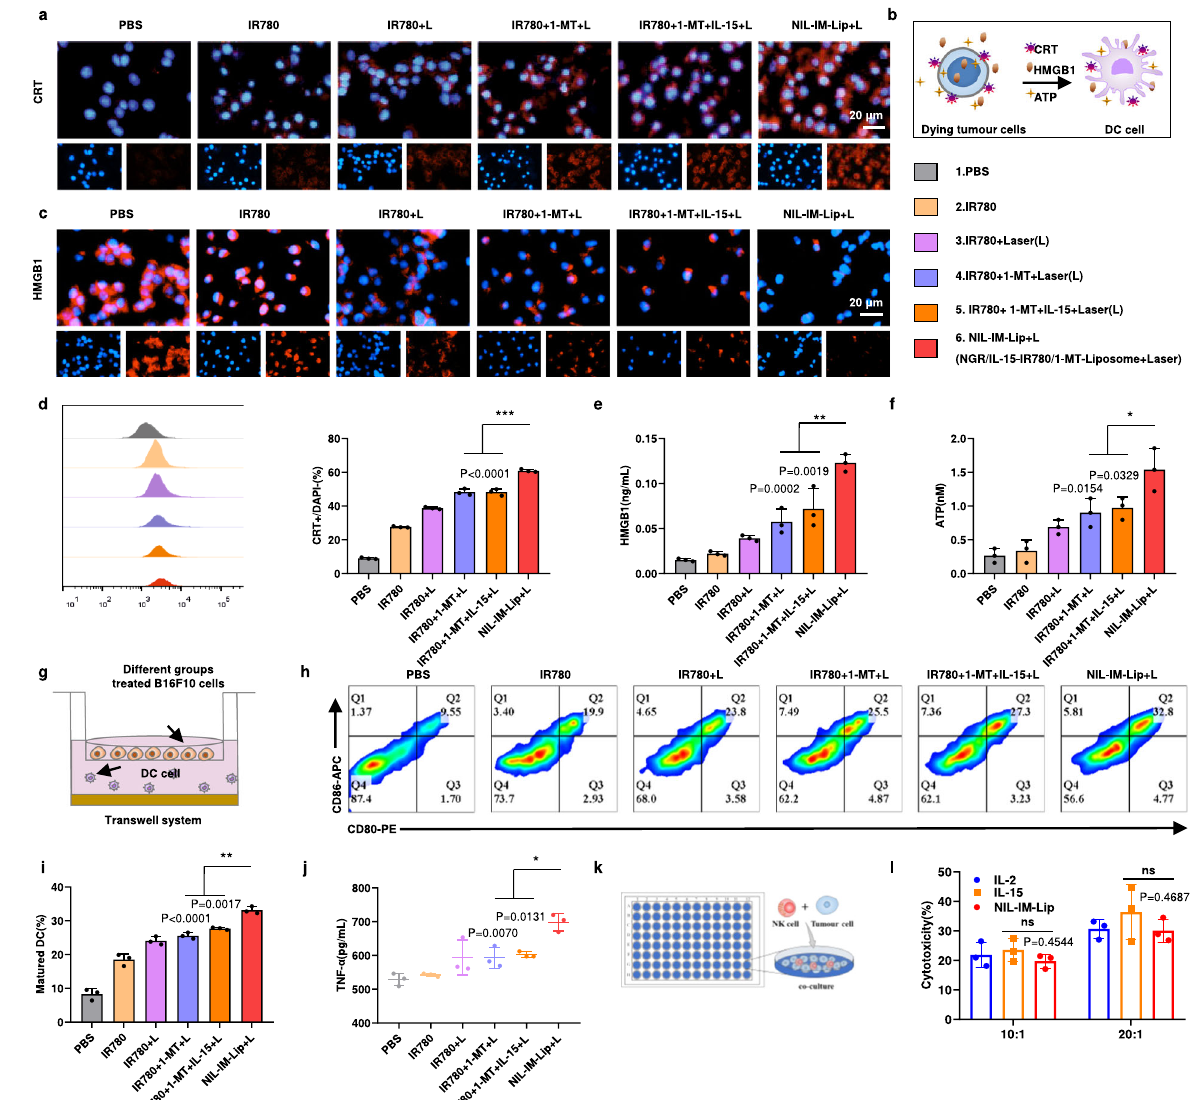
f Quantitative ELISA analysis of ATP secretion into the B16F10 culture medium supernatant( n = 3biologicallyindependentexperiments). g Schematicillustration of the transwell system used for DC maturation detection. h , i , Flow cytometric analysis of the ratio of mature DCs after coculture with B16F10 cells